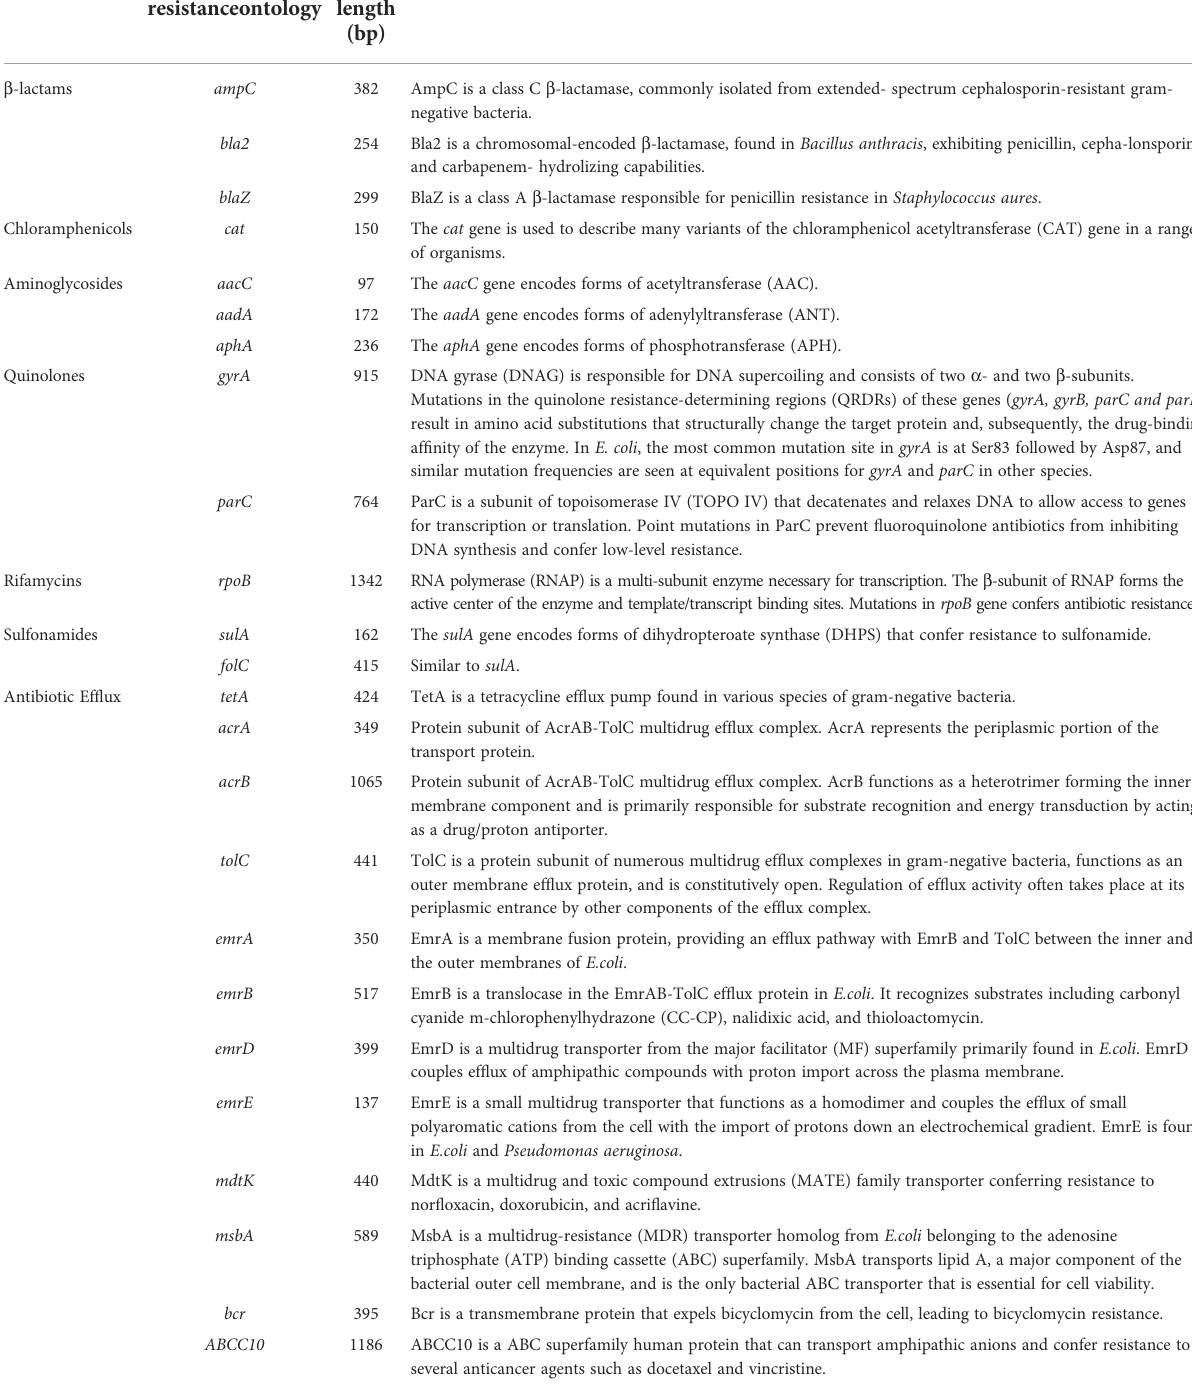
TABLE 3 Resistance genes of the A. hydrophila MX16A genome extracted by CARD and Nr analysis.